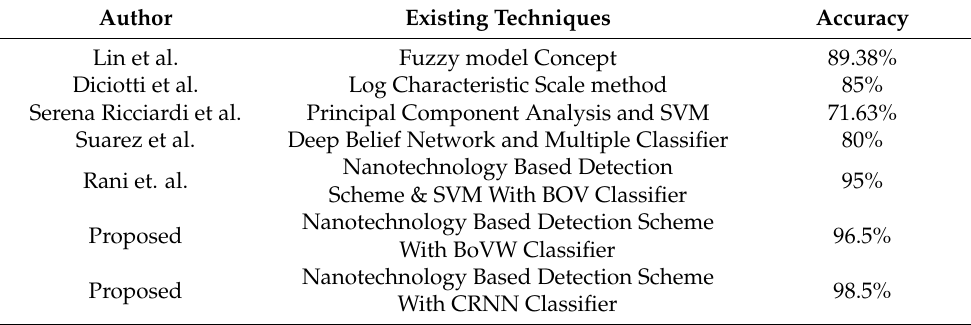
Table 8. Comparison with existing lung tumor detection methods.